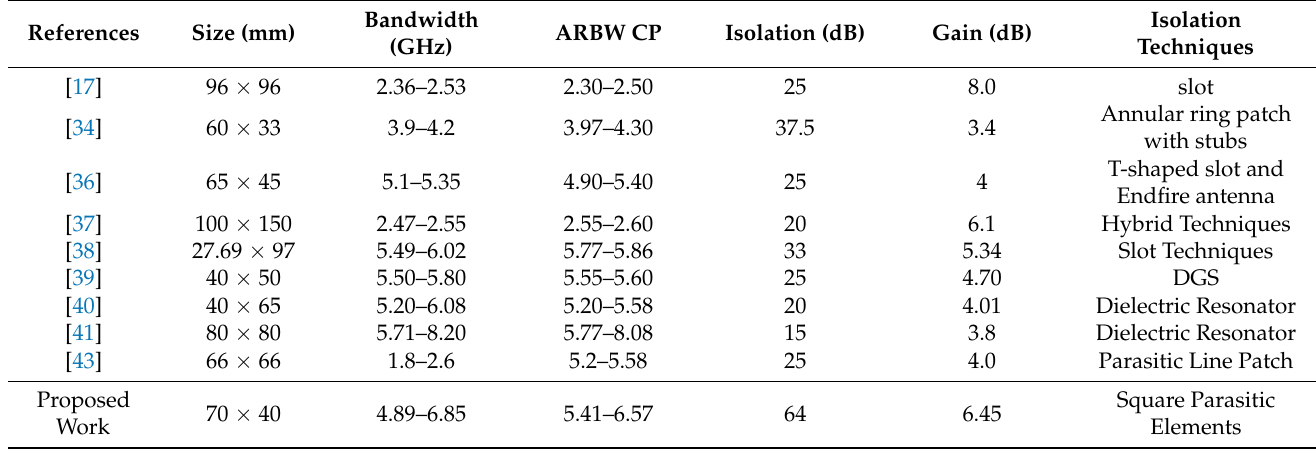
Table 3. Comparison with another MIMO antenna based on